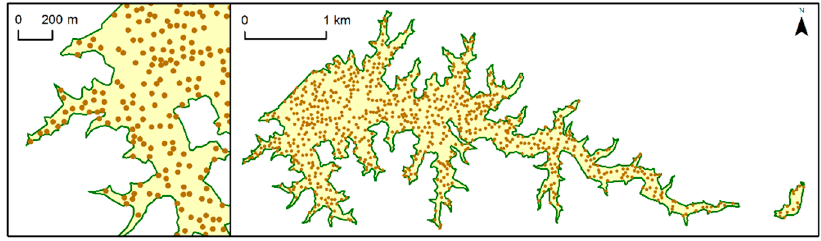
Figure 3. Example of random points distribution.